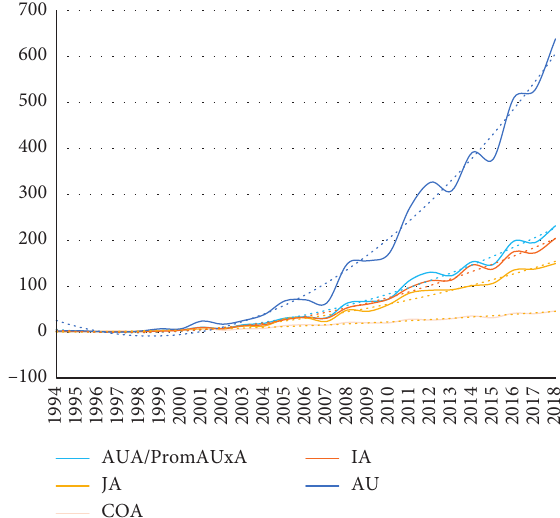
Figure 3: Number of authors, institutions, countries, and journals per year (1994–2018). Source: own elaboration with Web of Science and Scopus data